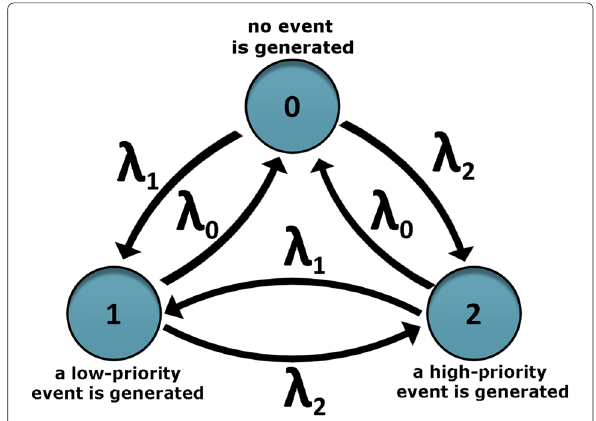
Fig. 3 Markovian model of the event generation scheme. Note that states in this diagram represent the type (priority) of the generated